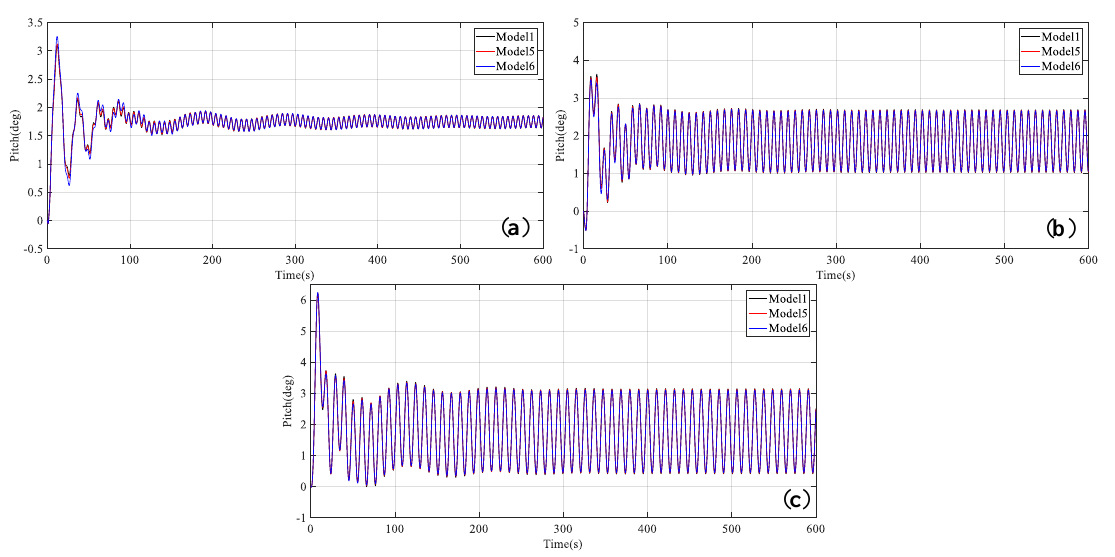
Figure 15. Time domain curves of the heave motion of the inclined upper column models: ( a ) LC1; ( b ) LC2; and ( c ) LC3.